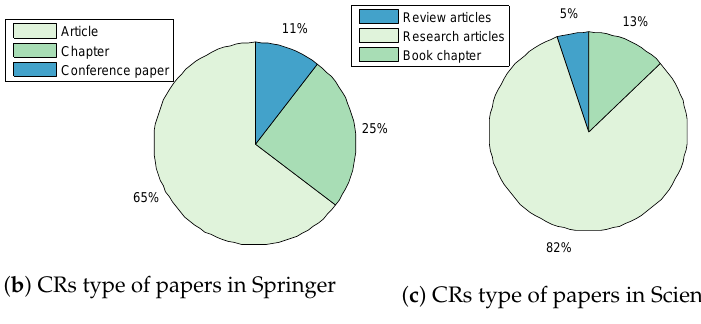
Figure 2. Evolution and classification of CRs publications.